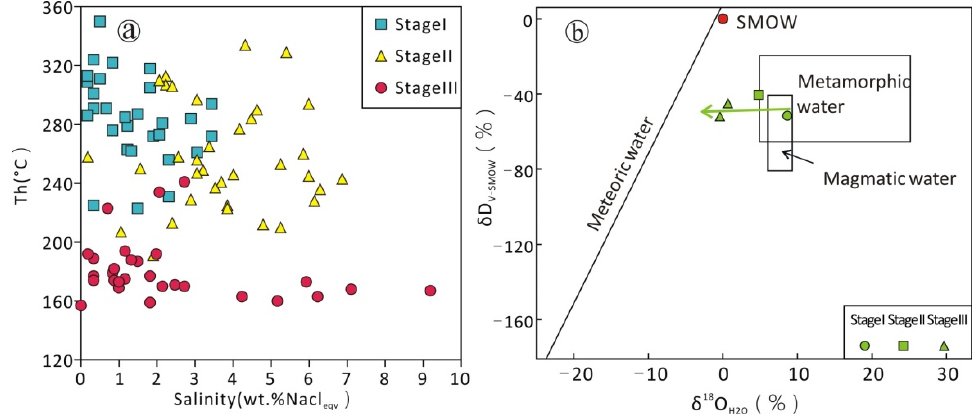
Figure 8. The temperature and salinity diagram of the Xialiugou deposit ( a ); δ D v-smow and δ 18 O H2O diagram for fluids of the Xialiugou deposit ( b ), modified from references [40,41]. Table 2. The δ D V-SMOW and δ 18 O V-SMOW values of the fluid inclusions in quartz, and calculated values for equilibrium fluids from the Xialiugou deposit.